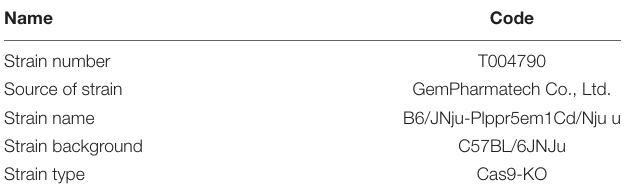
TABLE 2 | Strain information of knockout